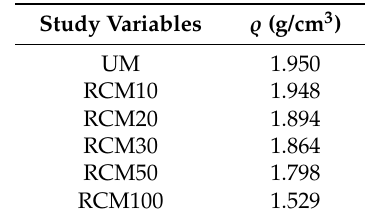
Table 3. Density in hardened state of the RCM.